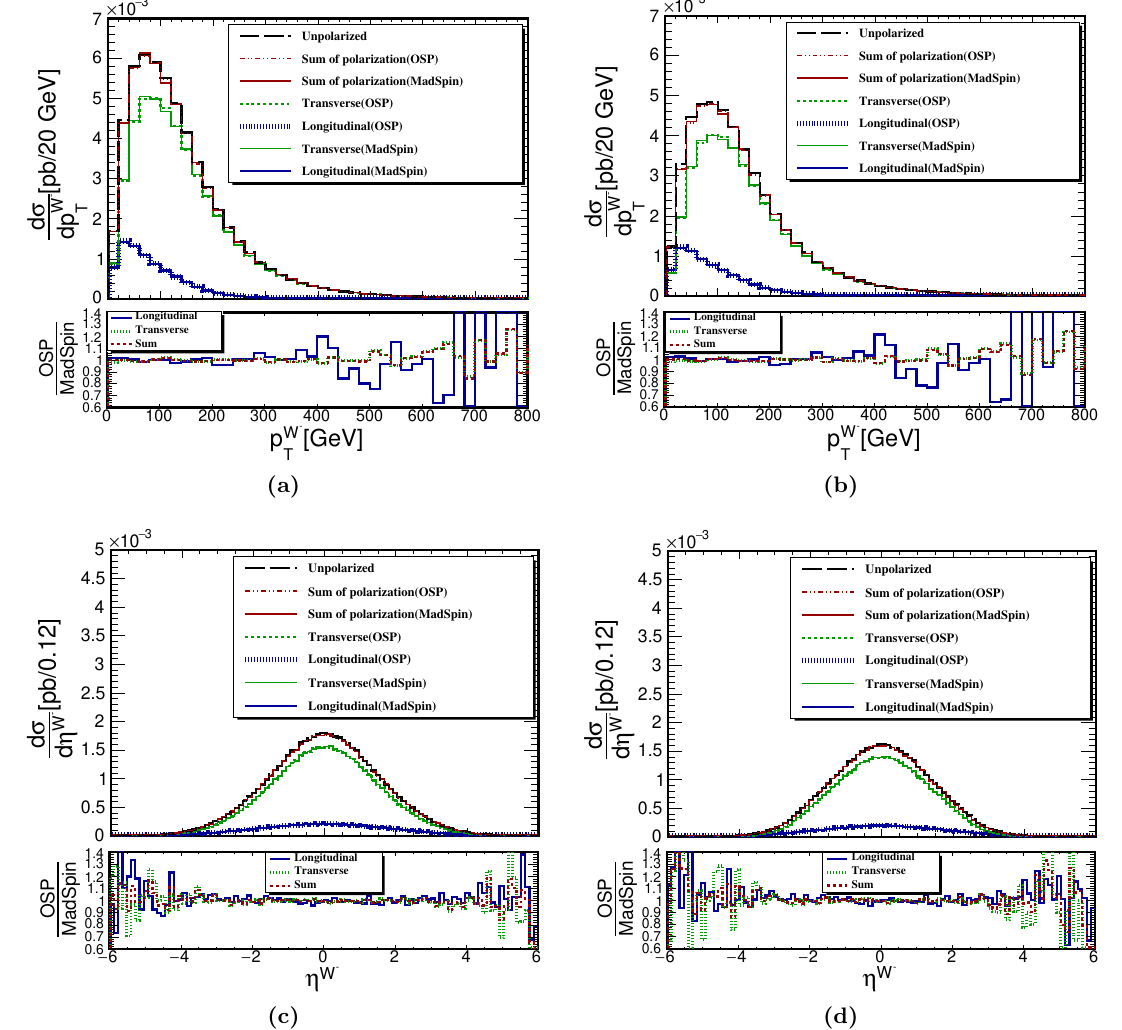
Figure 10. Same as (cid:12)gure 6 but for the mixed EW-QCD process pp ! jjW + W (cid:0)